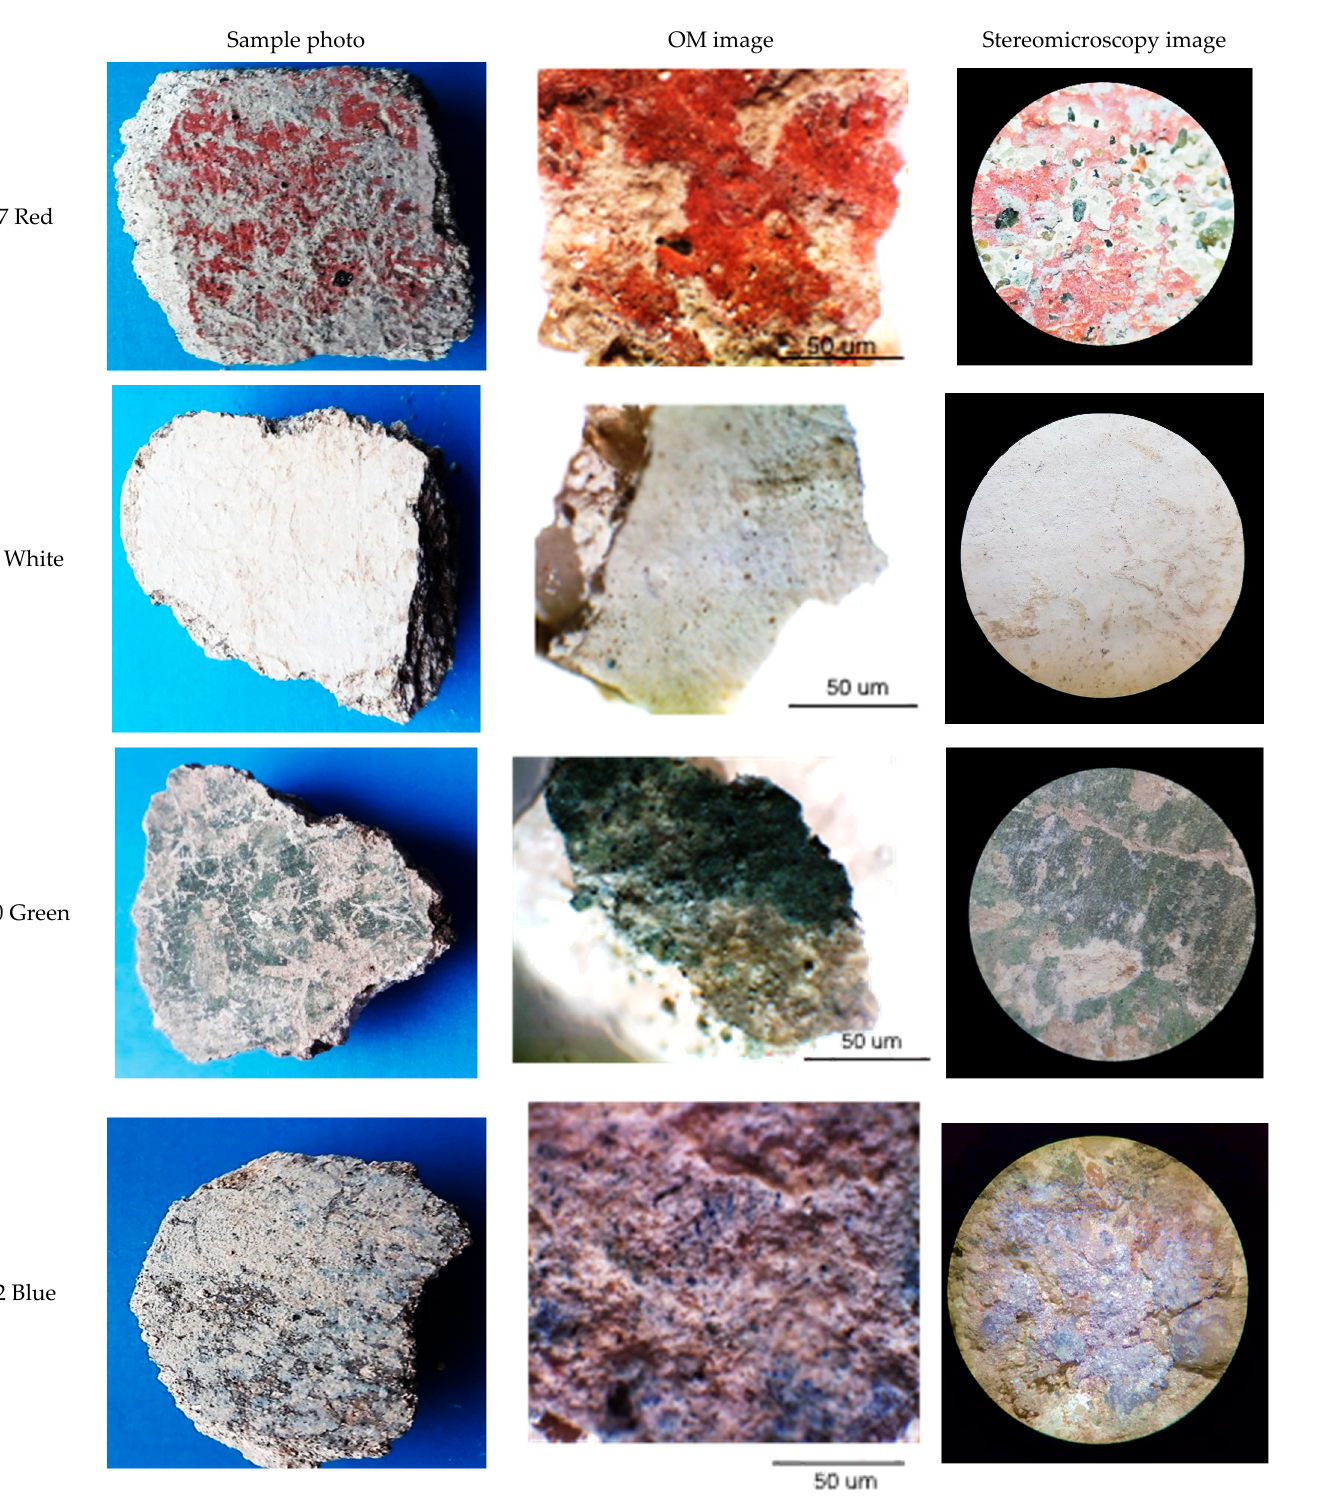
Figure 5. Photos, OM and zoom microscopy of the investigated samples.